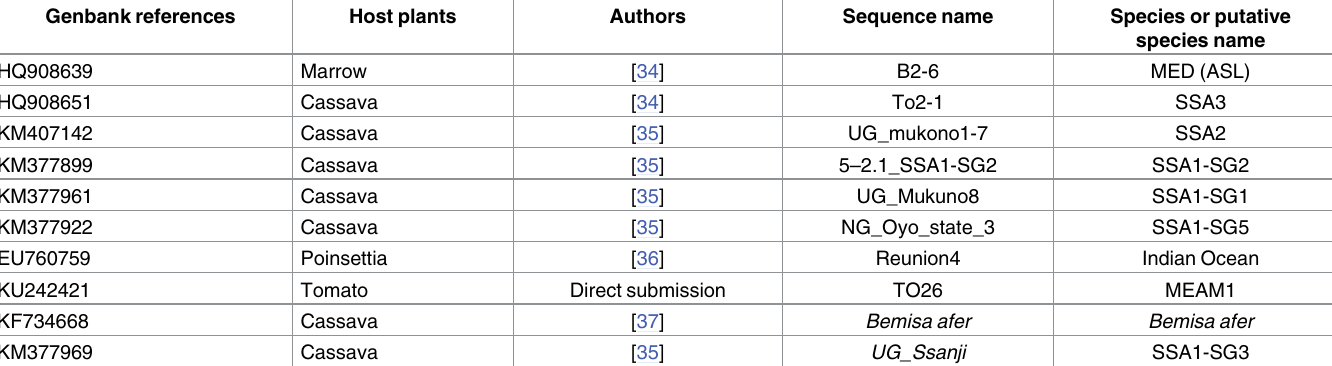
Table 1. Bemisia tabaci mtCOI sequences used to construct the phylogeny and haplotype network retrievedfrom